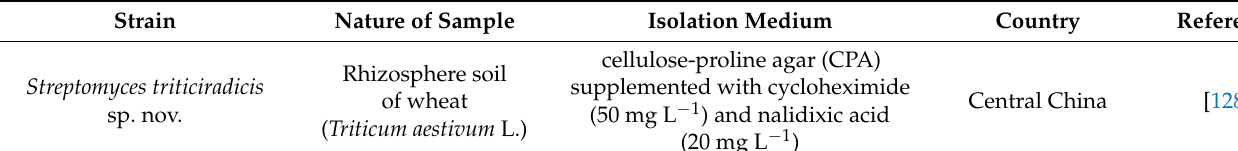
Table 4. Novel Streptomyces spp. reported from terrestrial soil samples between 2015 and